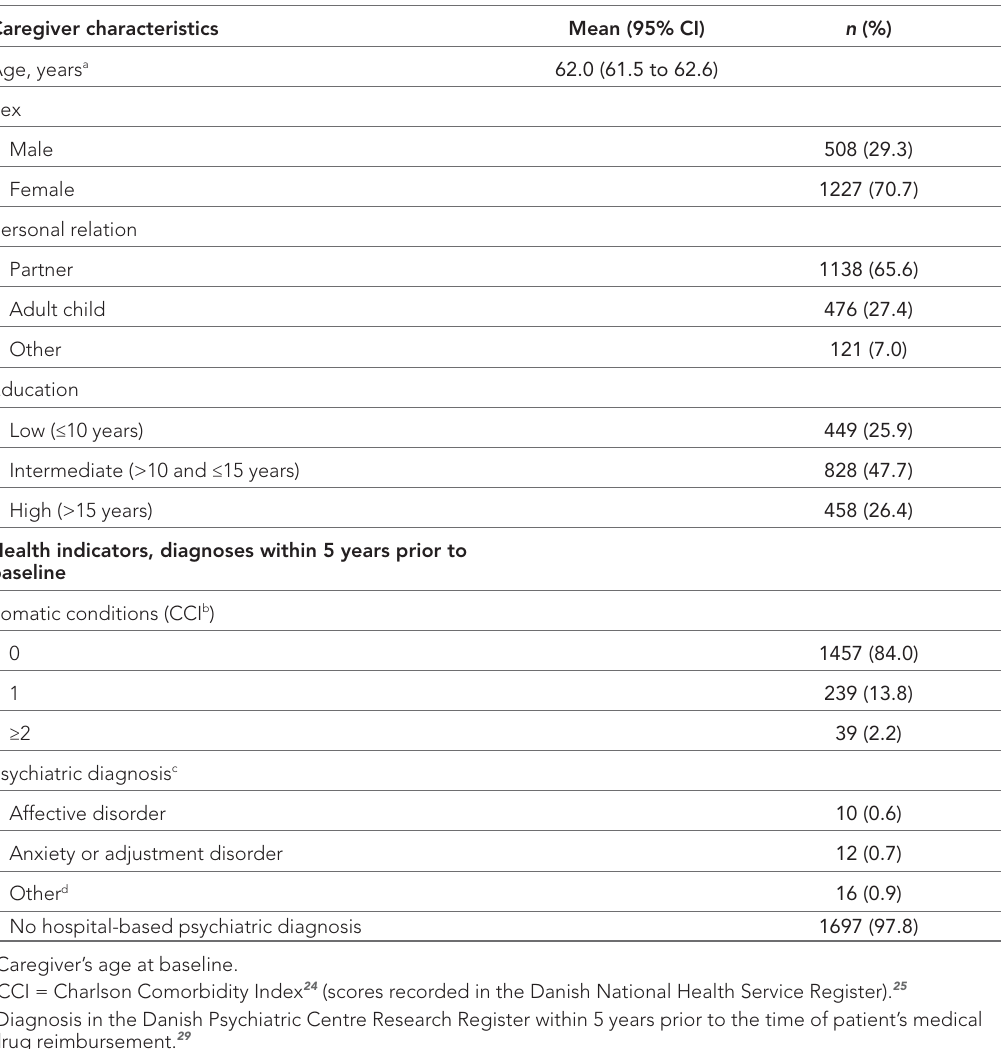
Table 1 Characteristics of the total study cohort at inclusion (baseline), N =